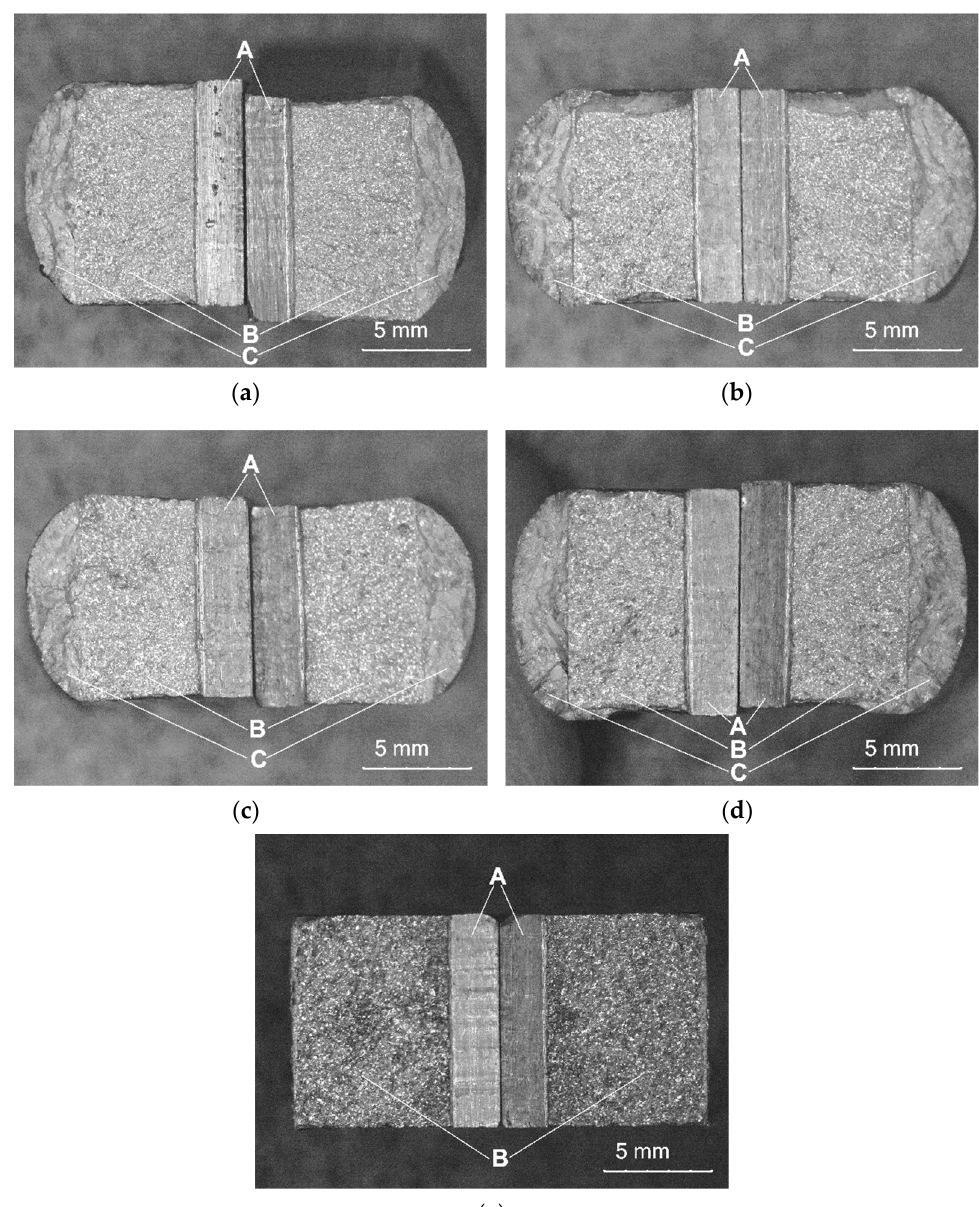
Figure 9. View of the sample before the Charpy impact test: ( a ) view from the weld overlay; ( b ) view from the Charpy V notch.